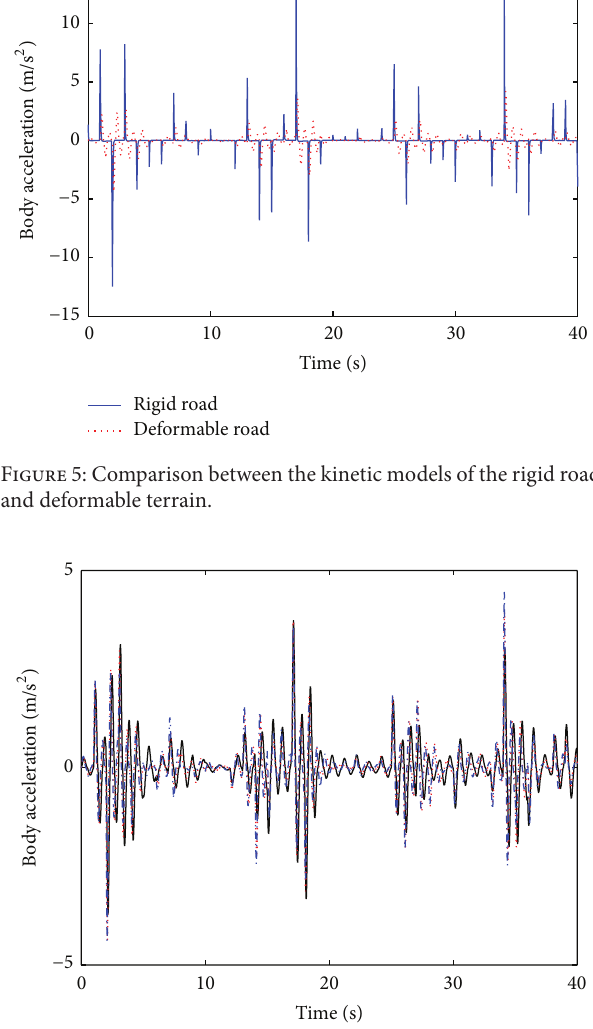
Table 1: Parameters of the manned lunar rover used for the simulations.